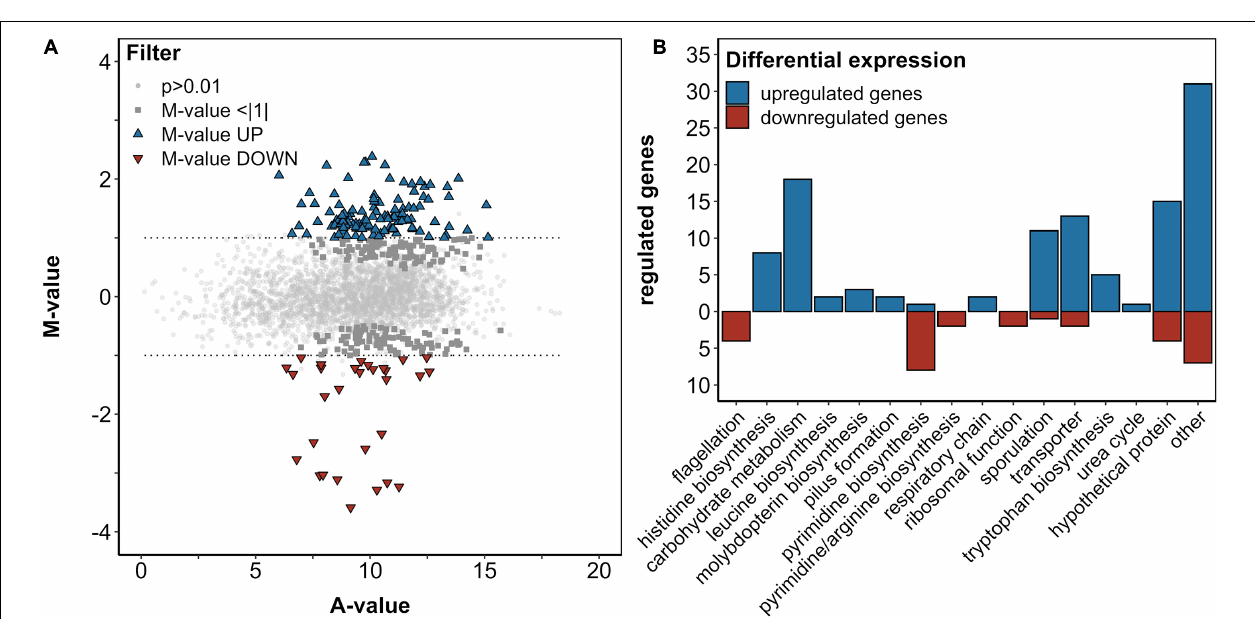
FIGURE 2 | Growth of B. methanolicus WT with 5AVA as a carbon/nitrogen source. B. methanolicus WT was cultivated in MVcM medium supplemented with 5AVA as a carbon source (blue circles) and as a nitrogen source (green diamonds) or with methanol as a carbon source and ammonium sulfate as a nitrogen source (black squares). Values and error bars represent means and standard deviations of triplicate cultivations.